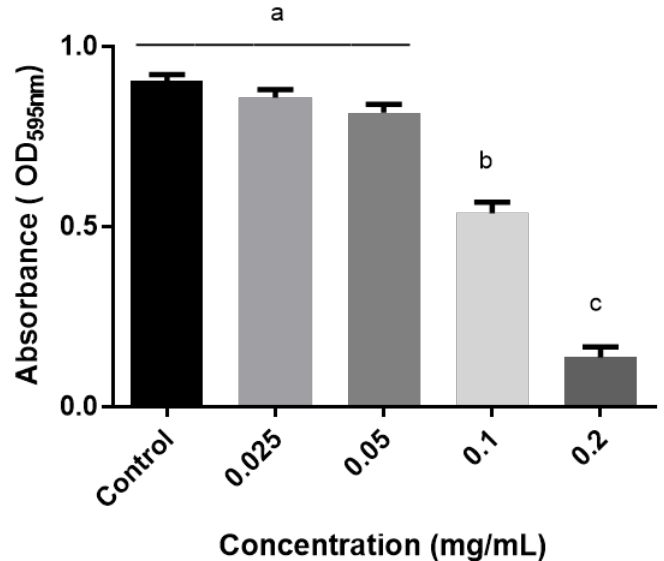
Figure 4. Violacein production in CVO26 bacterial strain during treatment with thymol-carvacrol-chemotype (II) oil from Lippia origanoides . Data are presented as mean ± SD of absorbance (at 595 nm). ANOVA ( p < 0.05) was performed, followed by Tukey’s Test. Different letters indicate significant differences between the test groups.